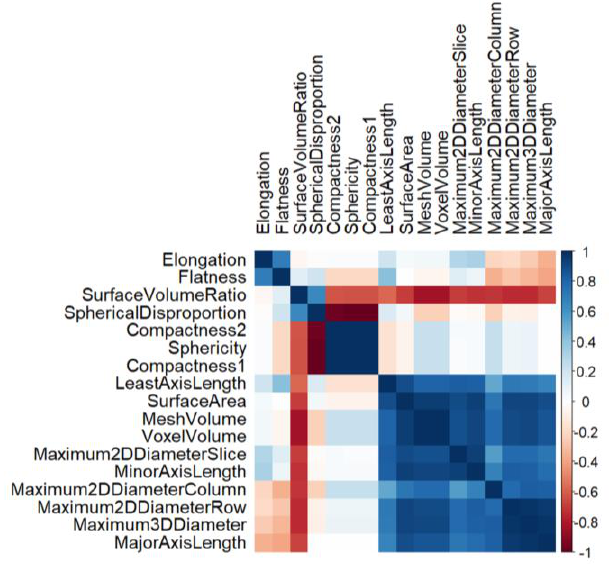
Figure 2. Clustered correlation matrix of the morphological